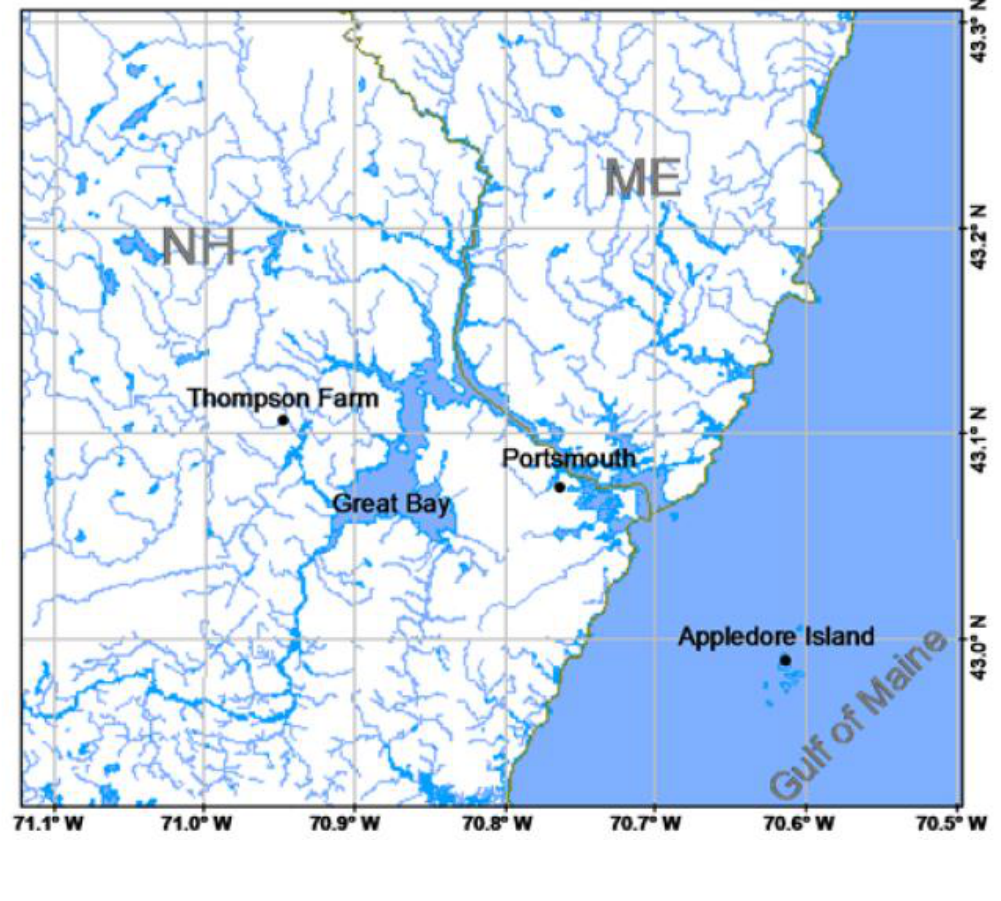
Figure 8. Region of interest for this study along coastal New Hampshire.